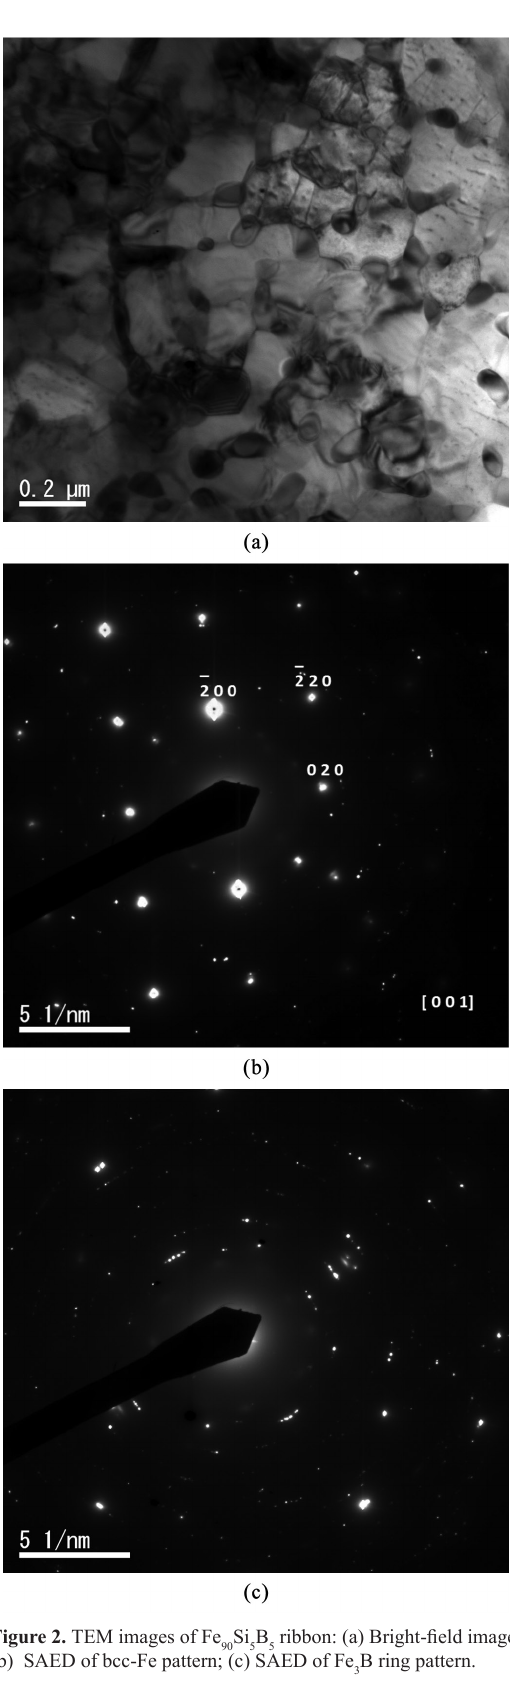
Figure 2. TEM images of Fe (b) SAED of bcc-Fe pattern; (c) SAED of Fe